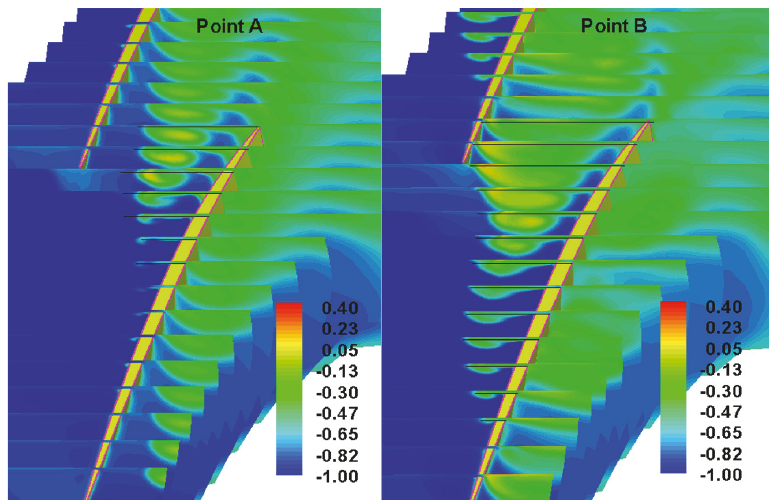
Figure 11: The axial-radial slices of entropy contours that show the 3D complex surface of MF/TLF interface ([14]). Points A and B are the ones marked on the left of Figure 9(a). Figure reproduced from CAMERON et al. (2013).